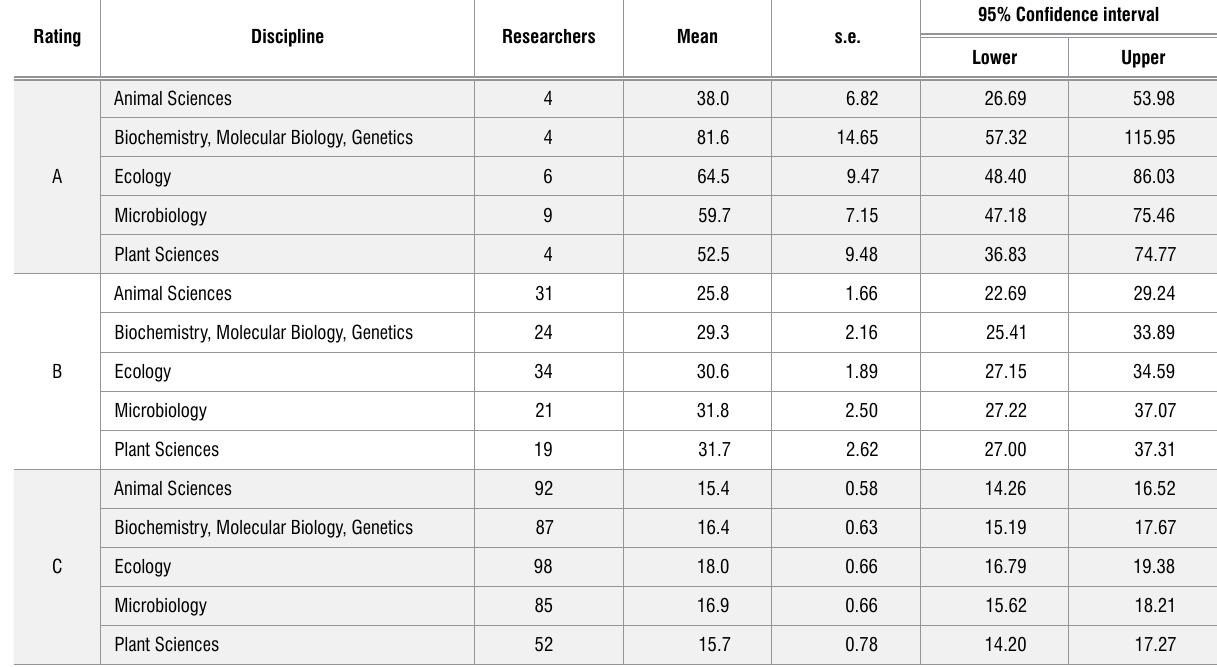
Model-adjusted (marginal) mean h -index values for sub-disciplines within each NRF rating category